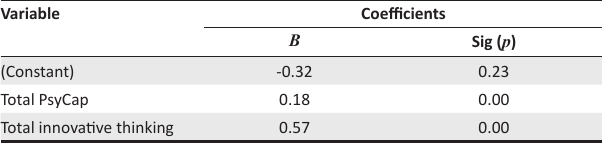
TABLE 6b: Total psychological capital and total innovative thinking combined